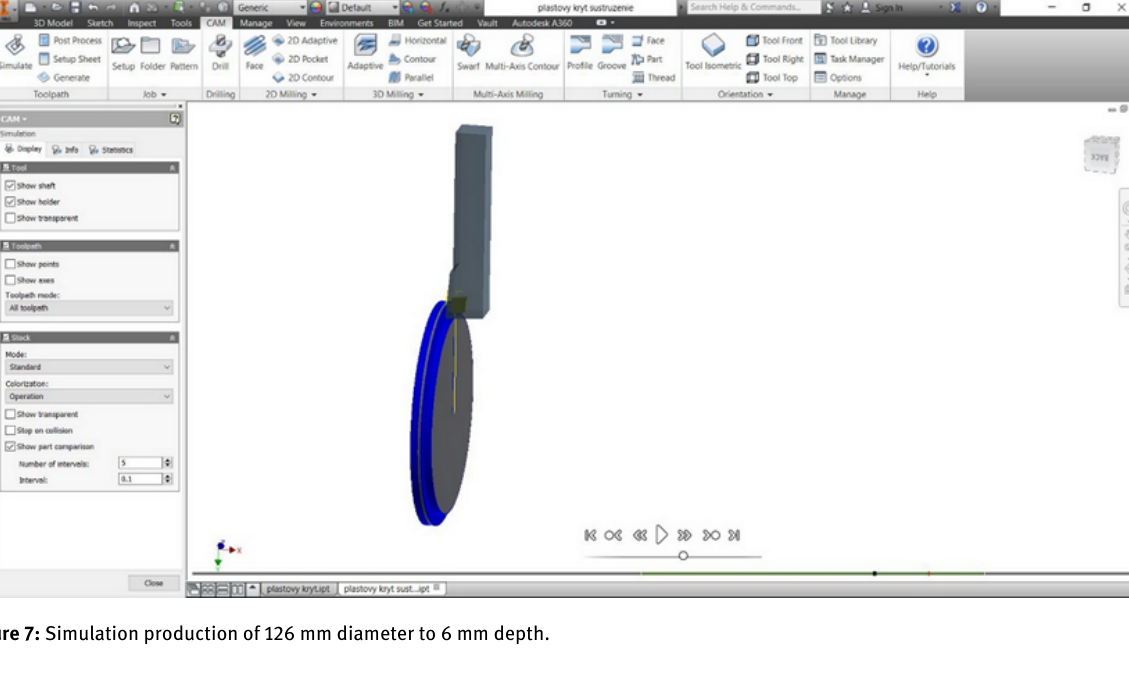
suring by that the alignment of the drilling tool and the prescribed hole axis position.